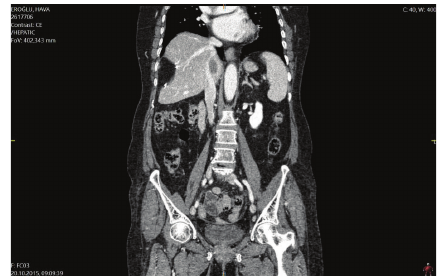
Figure 1: Sagittal section of a mass lesion at the caudate lobe compressing IVC. First resection site is also